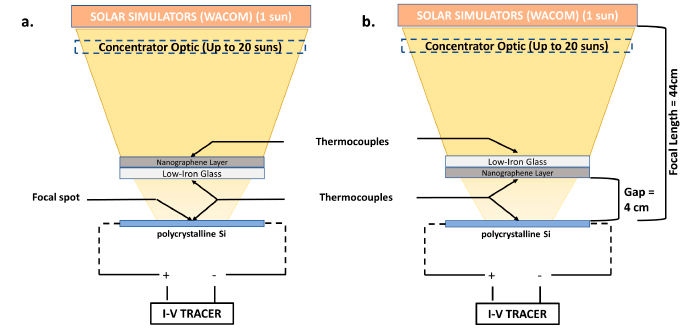
approach in which ( a ) graphene coating (GC) faces the source of the concentrated solar irradiance (Fresnel lens) and ( b ) GC faces the solar